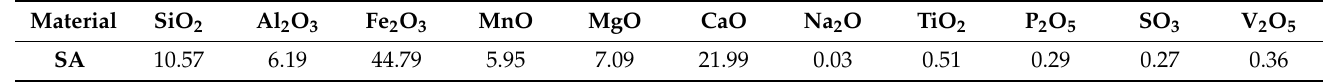
Table 1. Oxide composition of the different fraction of siderurgical aggregates (% wt.).